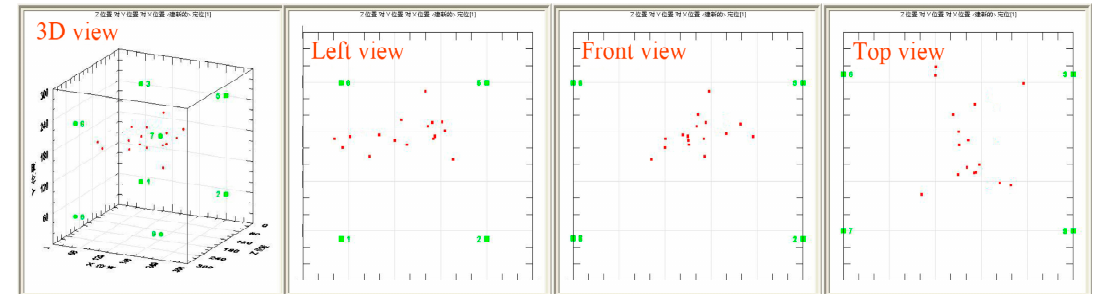
Figure 14. Spatial arrangement of acoustic emission events in the zero tree-type branch borehole hydraulic fracturing model.